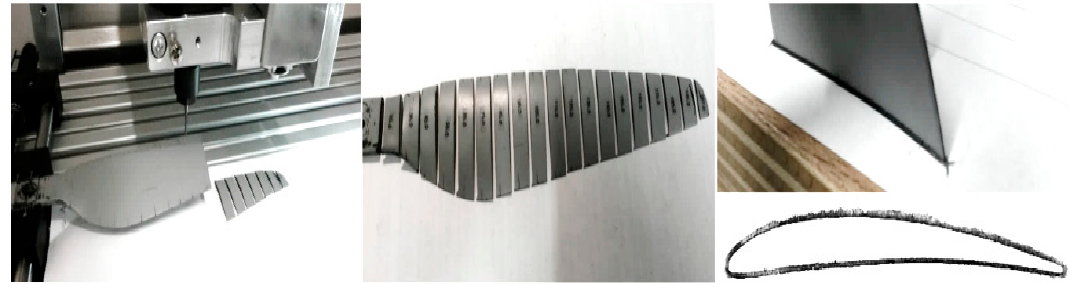
Figure 5. Rotor airfoil tracing method. Cuts obtained at various rotor span stations using a CNC mill.